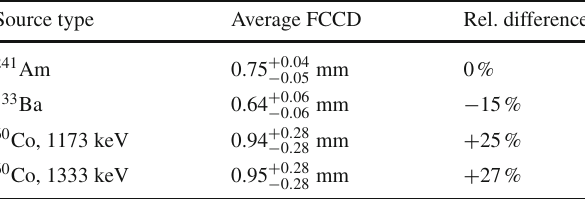
Table3 Gerda PhaseIIBEGedetectors:averagedFCCDvaluesbased on different source types. The uncertainties include the correlated and uncorrelated averaged terms. The relative difference corresponds to the difference of 133 Ba and 60 Co based FCCD averaged values from the 241 Am based result Source type Average FCCD Rel. difference